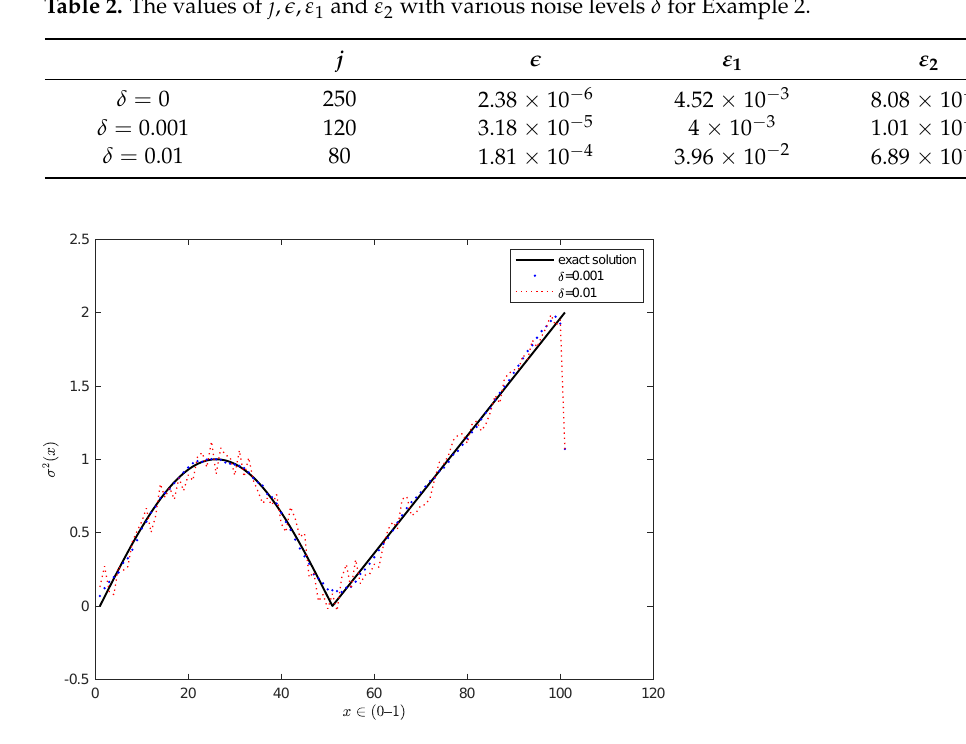
Figure 4. Numerical solution of unknown function σ 2 ( x ) for Example 2 with noisy input